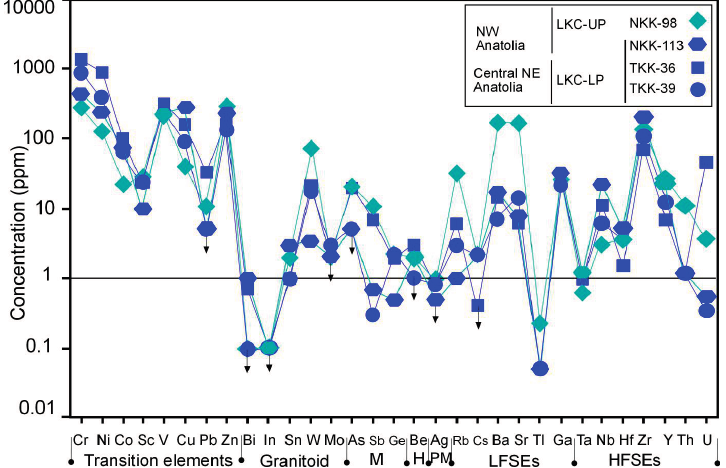
Figure 12. The correlation of chlorite minerals in the Karakaya Complex units according to the contents of trace elements (Arrows show values below the detection limits, M = Miscellaneous elements, H = Halogen elements, PM = Precious metals, LFSEs = Low field strength elements, HFSEs = High field strength elements).